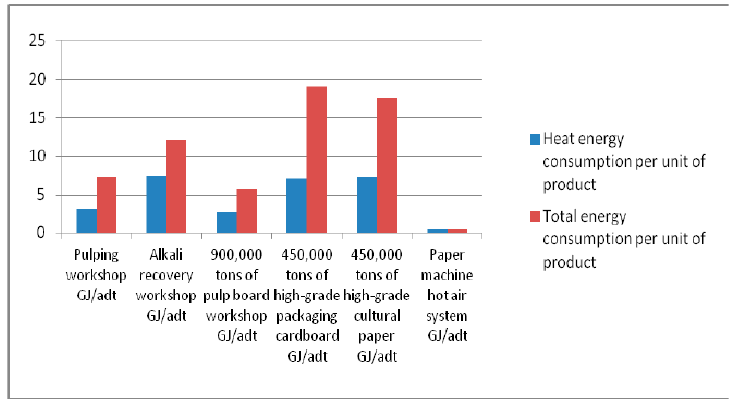
Figure 5. Energy consumptions of the main production units.